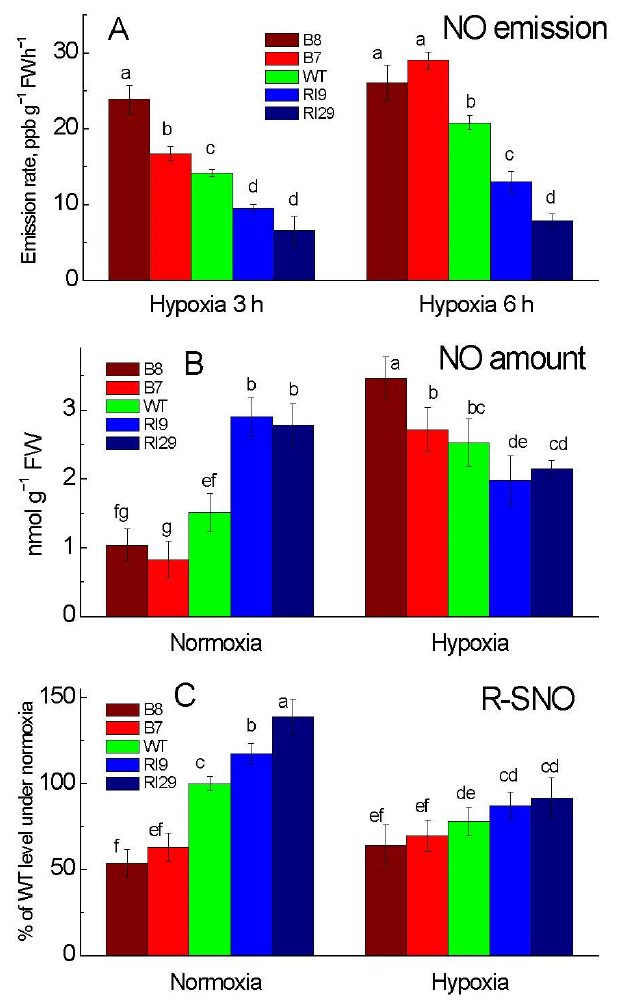
Figure 1. Leaf nitric oxide emission ( A ), total NO amount ( B ), and S -nitrosylation level ( C ) in tobacco plants with differing amounts of alternative oxidase and exposed to normoxia or hypoxia (6 h, unless indicated different). The plant lines used included wild type (WT), two alternative oxidase overexpressors (B7 and B8), and two alternative oxidase knockdowns (RI9 and RI29). Vertical bars indicate SD from three to four independent experiments ( n = 3–4); different letters indicate significant differences between five tobacco lines and the treatments.